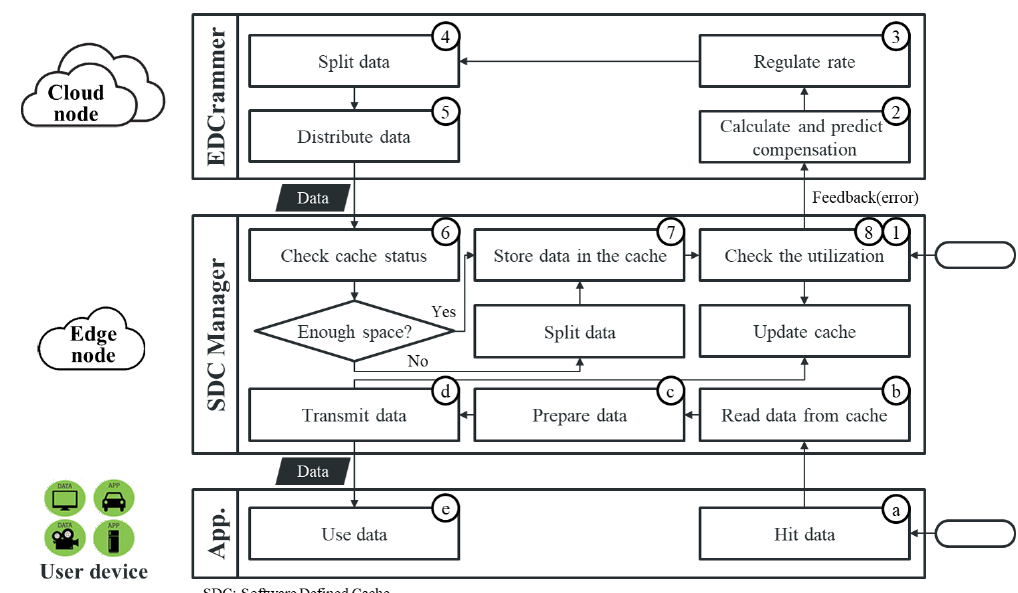
Figure 4. Overall flow for the data caching and hitting